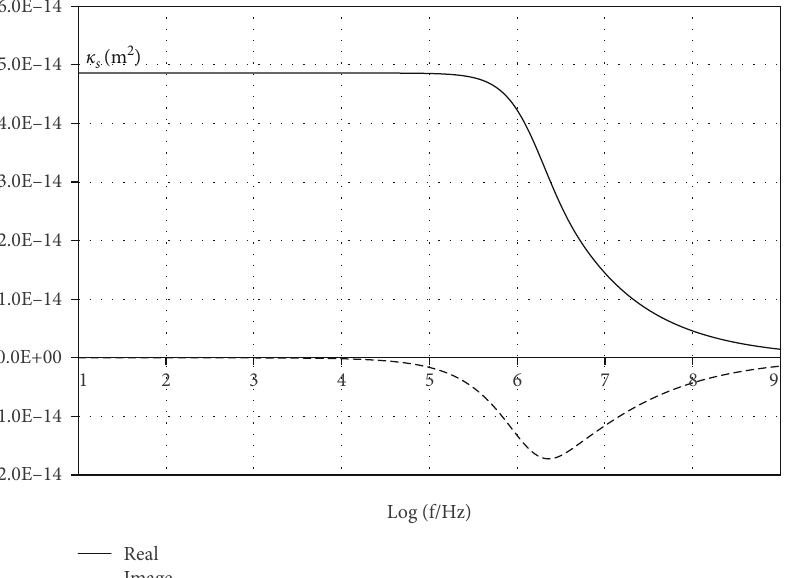
f ), for water-saturated D ’ Euville limestone under di ff erential pressure of Figure 3: S-wave permeability ( κ s ) as a function of frequency ( 3MPa.